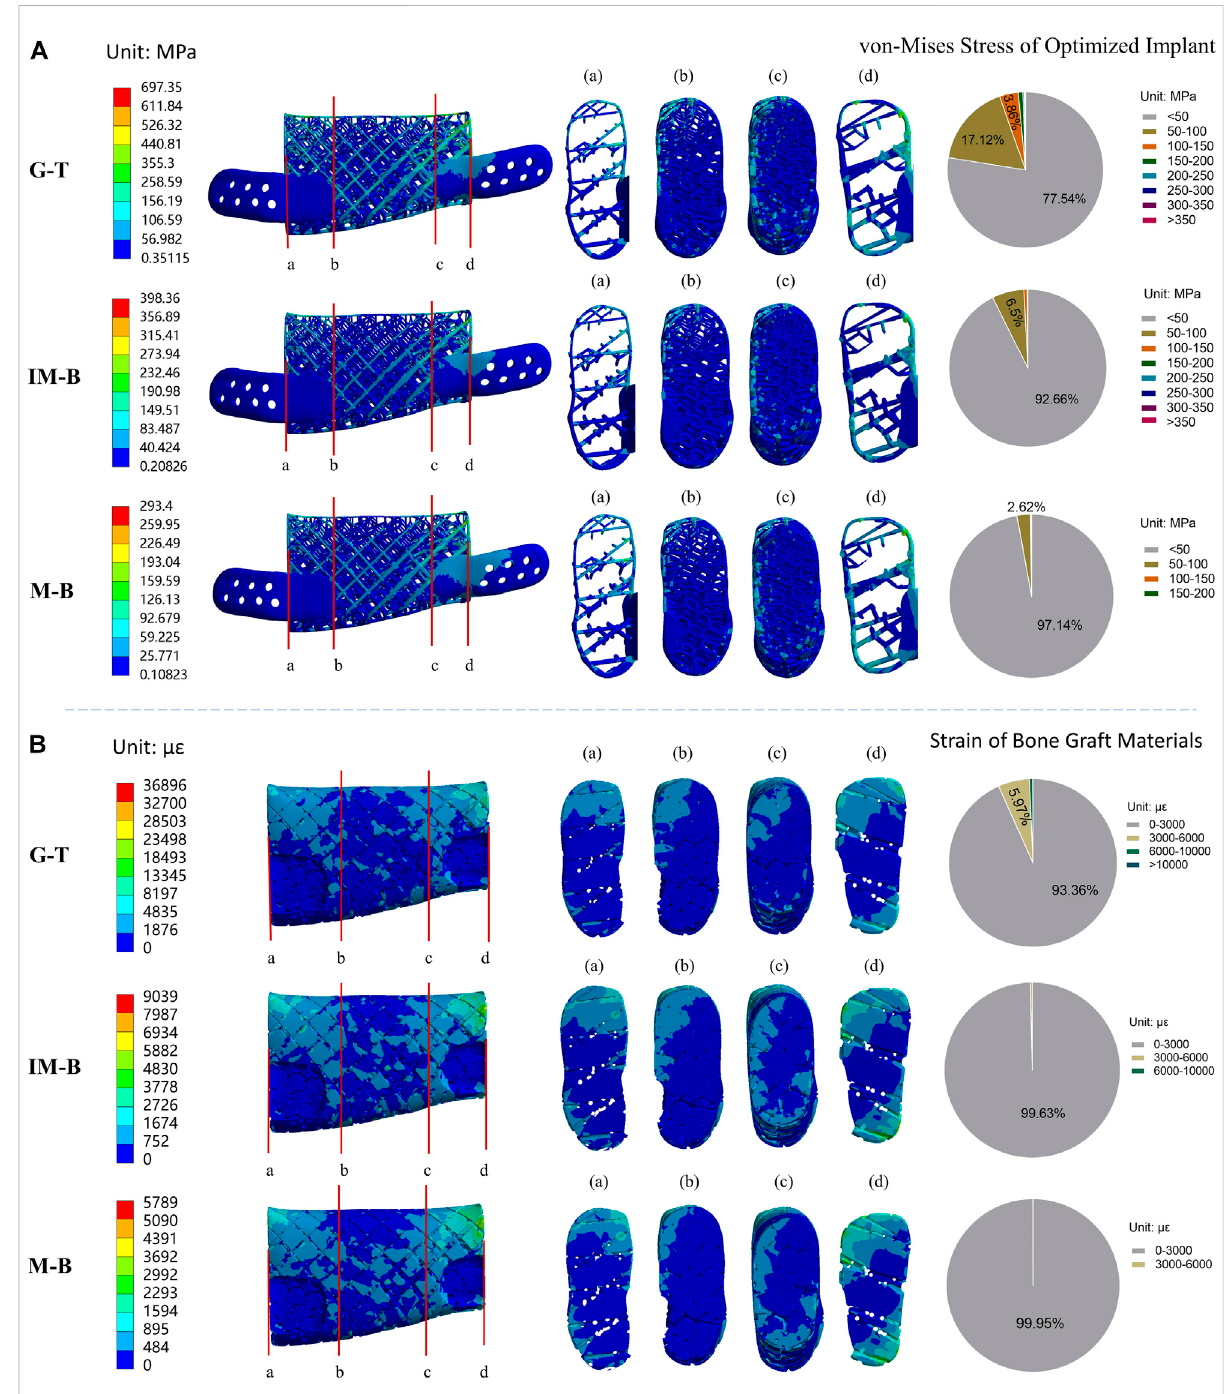
FIGURE 6 Von-Mises stress of optimized lattice-like implant and strain of bone graft materials in different periods. Granulation tissue (G-T) representing theearlystages,Immaturebone(IM-B)representingthemiddleperiodandmaturebone(M-B)representingthe fi nalperiod. (A) Thevon-Misesstress ofoptimizedimplantindifferentperiods. (B) Thestrainofbonegraftmaterialsindifferentperiods. (a – d) illustratedfoursectionsofvon-Misesstress/ strain for the original implant/bone graft materials. The pie charts show the frequency of von-Mises stress/strain for the original implant/bone graft materials in different